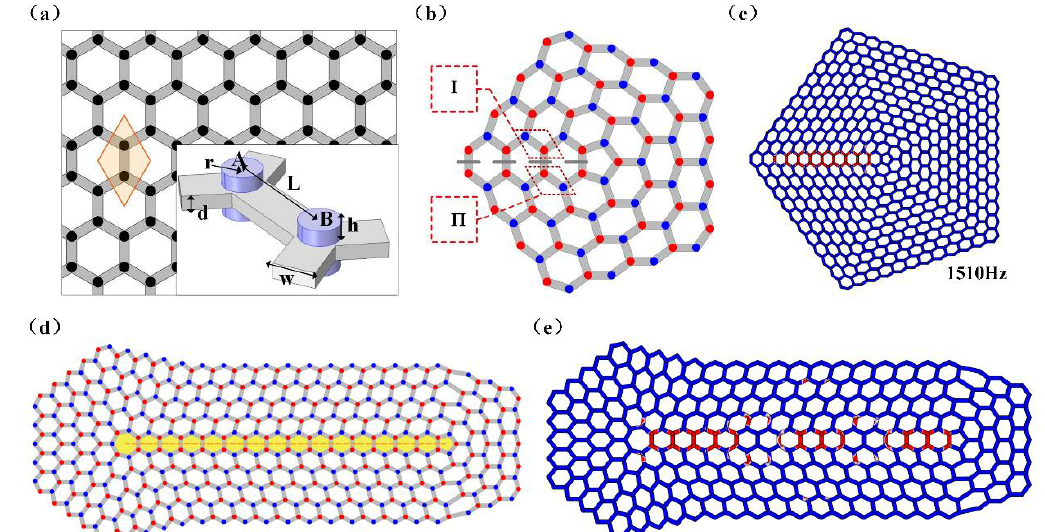
Figure 9. Valley-polarized structure with disclinations. ( a ) The hexagonal lattices with a rhombic (orange) unit cell. ( b ) The pentagonal elastic phononic plate with a pentagonal core and a new interface (gray dashes). The red and blue circles signal two categories of magnets with different heights ( h 1 = 1 mm and h 2 = 3 mm ). The unit cell I and II are displayed by the red parallelogram region. ( c ) One of the eigenmodes of the pentagonal elastic plate at 1510 Hz. ( d ) The composite elastic structure with a disclination dipole (a disclination connecting a pentagonal and heptagonal core) waveguide. ( e ) One of the eigenmodes of the composite elastic system at 1550 Hz.